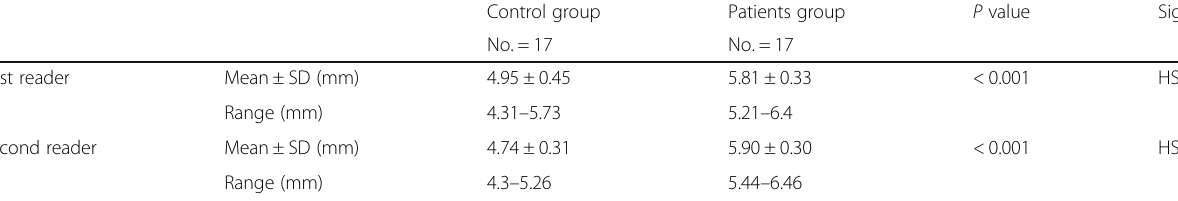
Table 2 ONSD mean value measured by the first and the second reader in the 3D DRIVE sequence in the control and patient group Control group